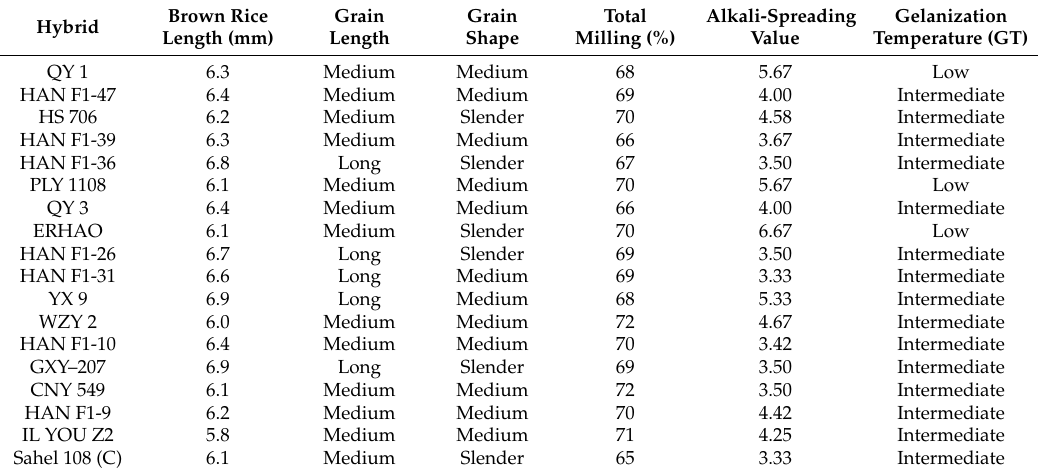
Table 5. Grain traits and milling properties of promising rice hybrids and cultivar check (C) Sahel 108 after harvest in Ndjaye, Senegal during 2009 wet